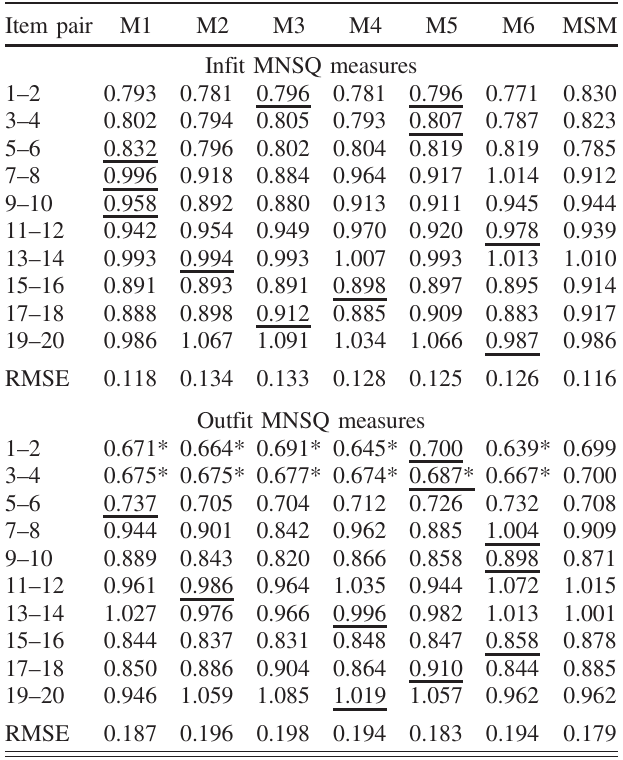
TABLE IV. Item fit indices of S2. For M1 – M6, the indices outside the range of 0.7 – 1.3 are marked with an asterisk (*) and the indices closest to 1.0 are underlined. Statistical analysis of the infit and outfit measures is discussed in the Supplemental Material [70].